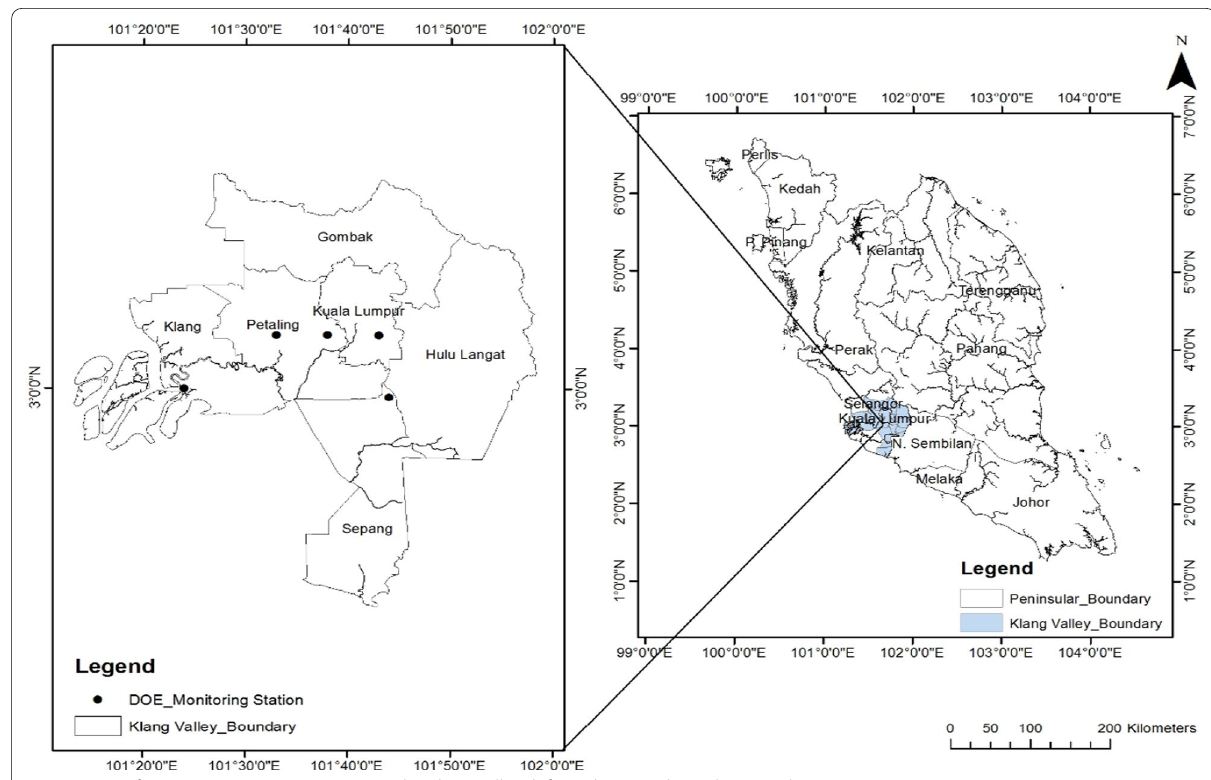
Fig. 1 Map of DOE monitoring station sites in the Klang Valley (left) and peninsular Malaysia (right)